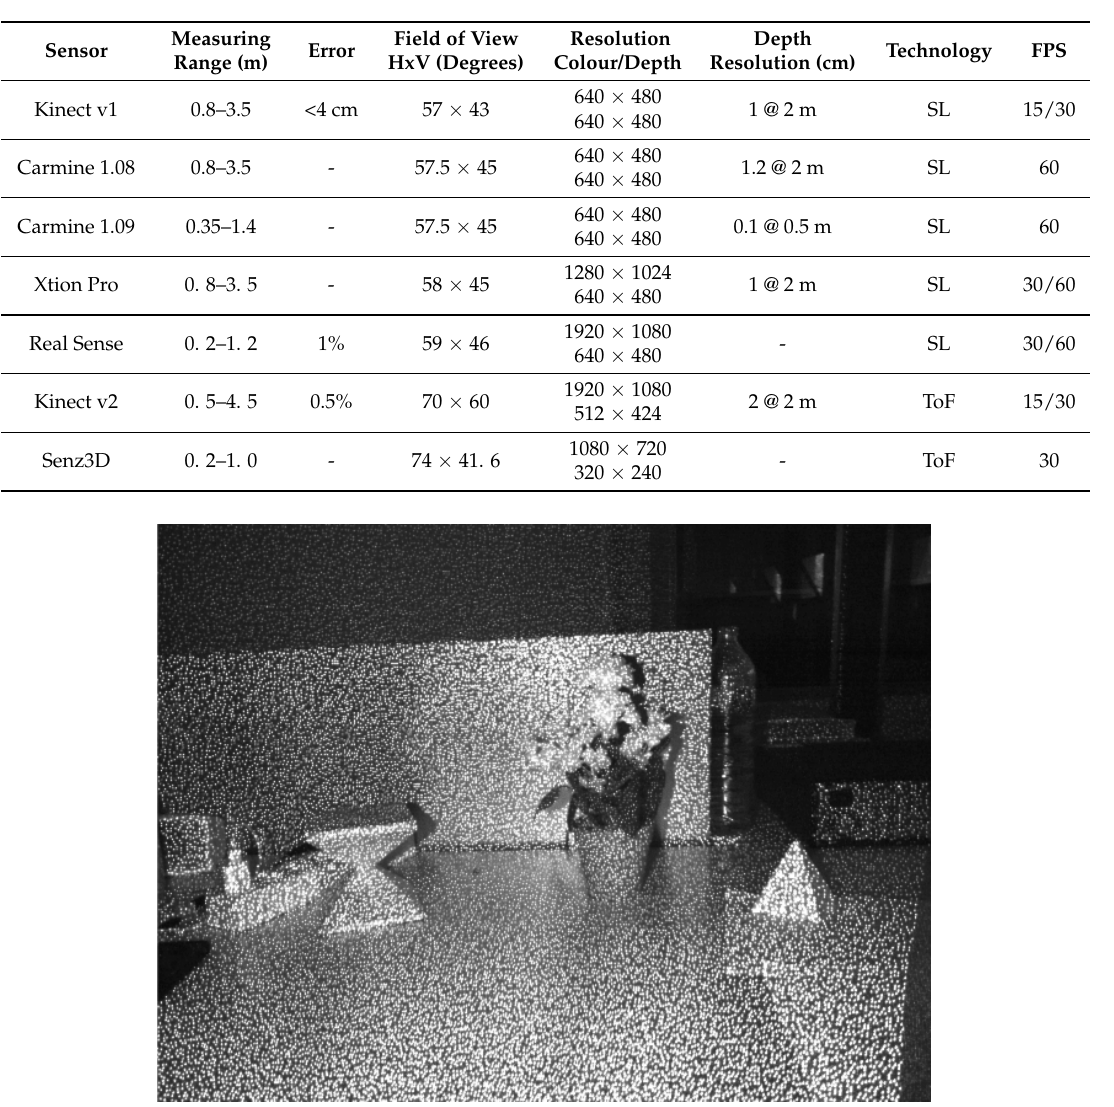
Table 1. Technical specifications of consumer RGB-D cameras. SL: Structured light, ToF: Time of Flight.